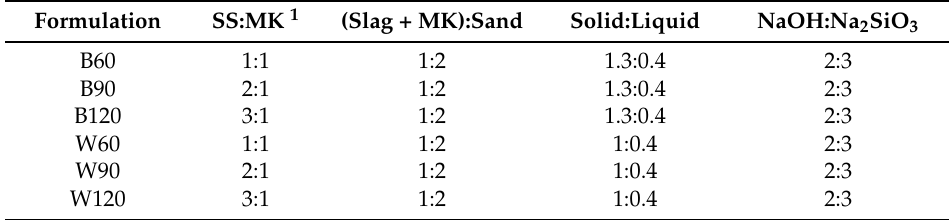
Mix-design of steel slag (SS) inorganic polymer mortars with similar value in the cone-fluidity